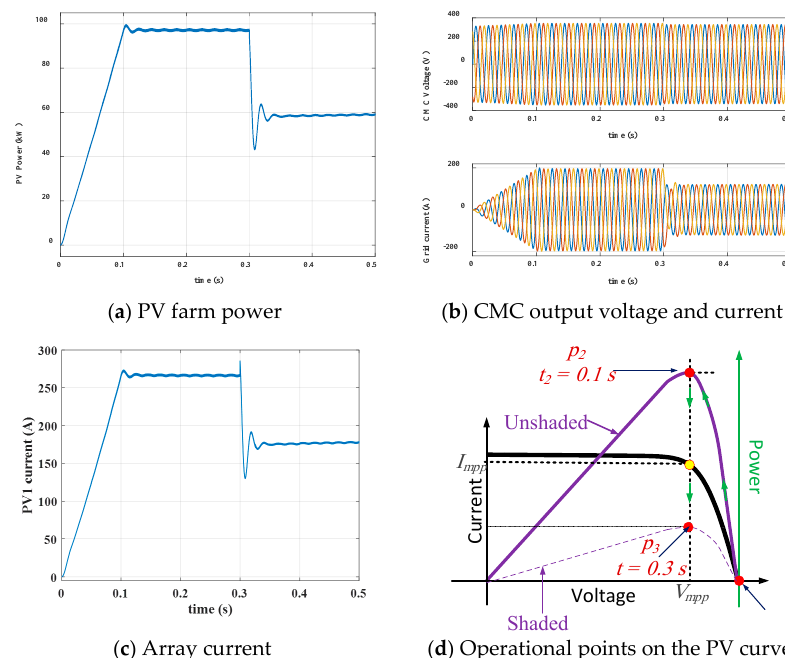
Figure 25. Mode 4 (from PV to grid) MATLAB/SIMULINK